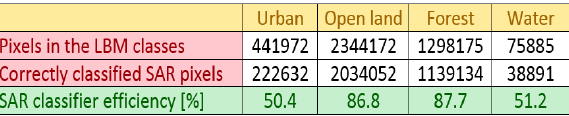
Table 2. Classification efficiency for test site